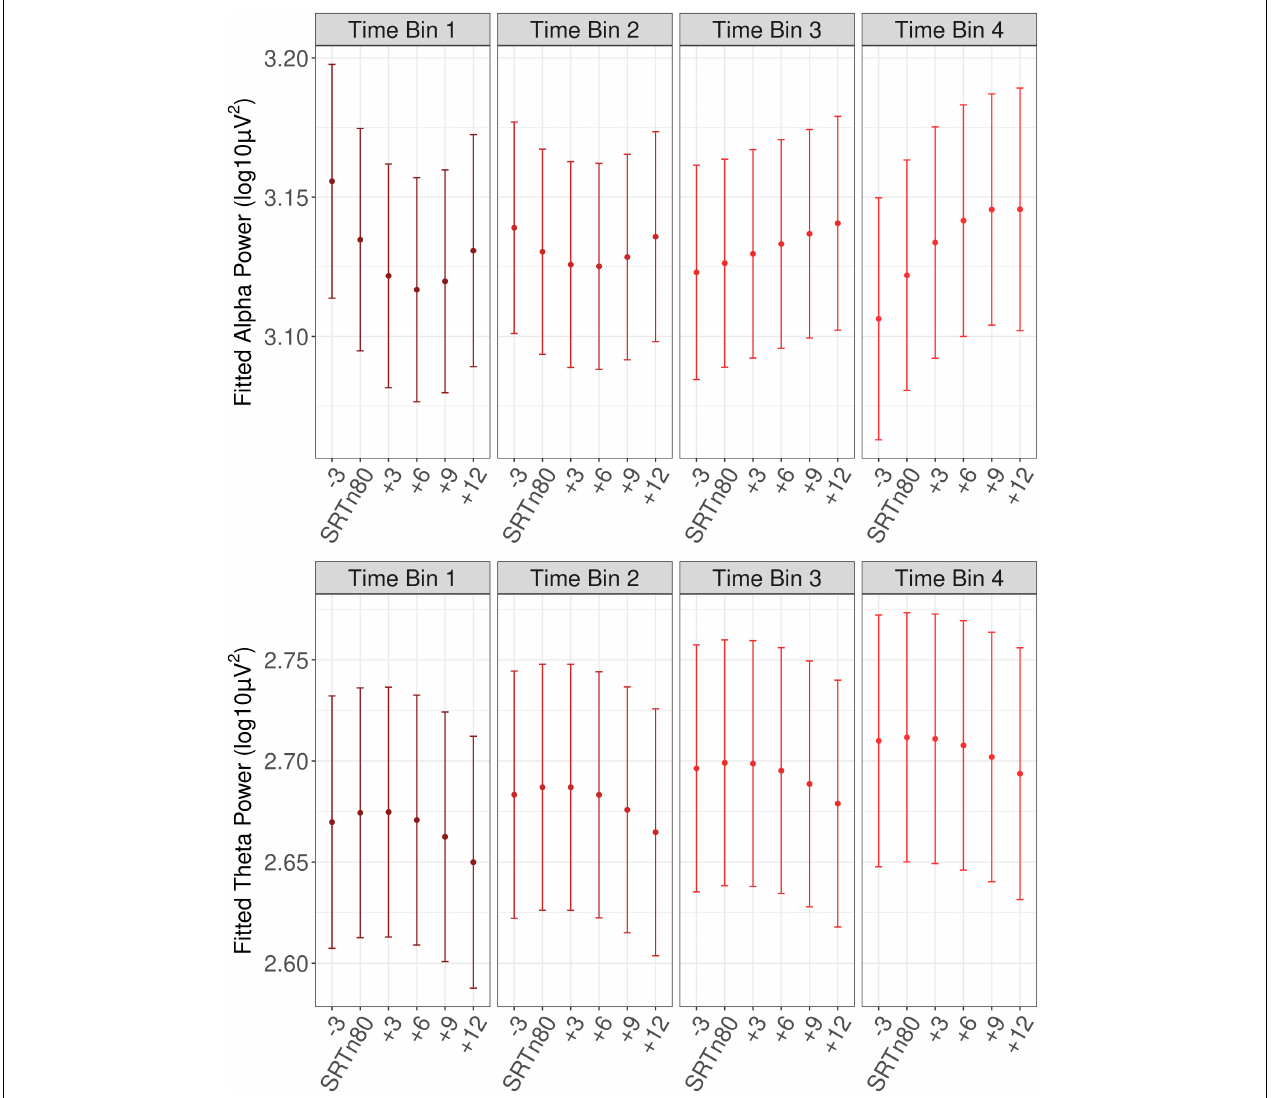
FIGURE 5 | Fitted oscillatory power as a function of SNR and time bin. Shown is fitted oscillatory power with error bars showing ± 1 SE. Time bins cover the first to fourth quartiles of trial numbers. SRTn80, the signal-to-noise ratio that approximates the 80 percent speech recognition threshold for each participant.